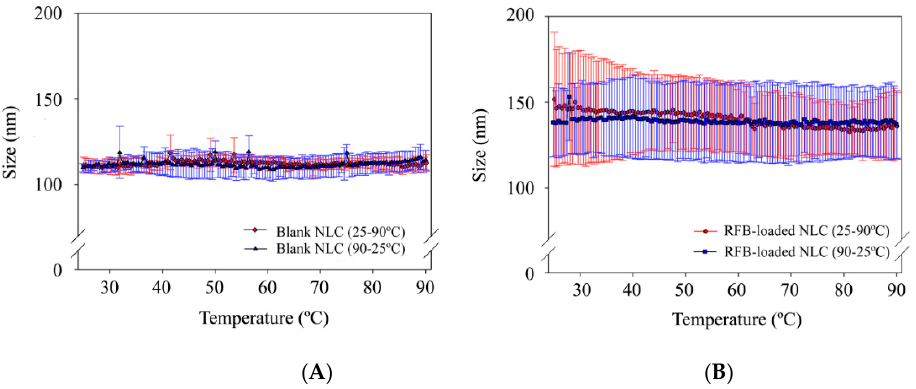
Figure 1. Dynamic light scattering thermograms of ( A ) Blank NLC formulations and ( B ) RFB-loaded NLC formulations.